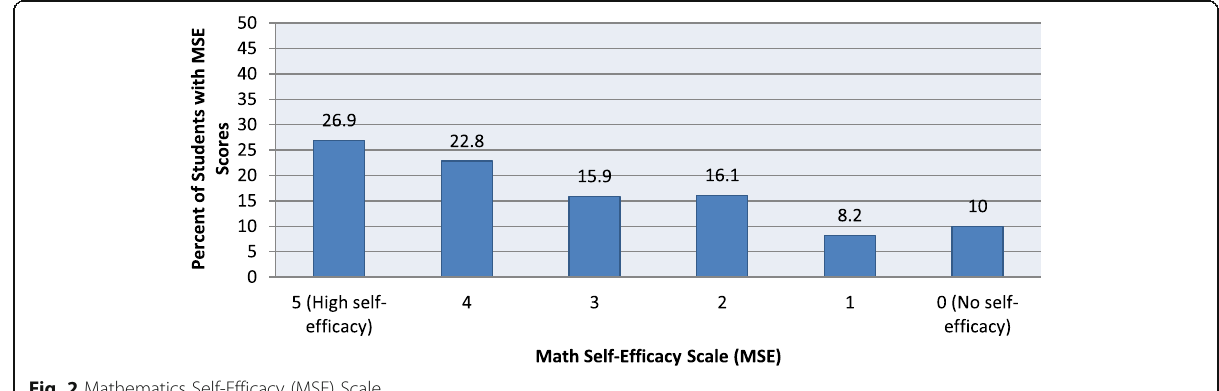
Fig. 2 Mathematics Self-Efficacy (MSE) Scale